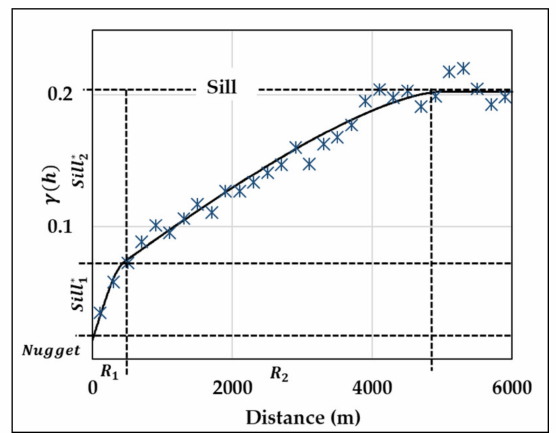
Figure 8. Example of variogram modelling: a nugget and two spherical nested structures are fitted on an experimental sample variogram. R 1 and R 2 refer to the ranges of the two nested models. Directional and omnidirectional variograms are analysed using a lag size of 25 m